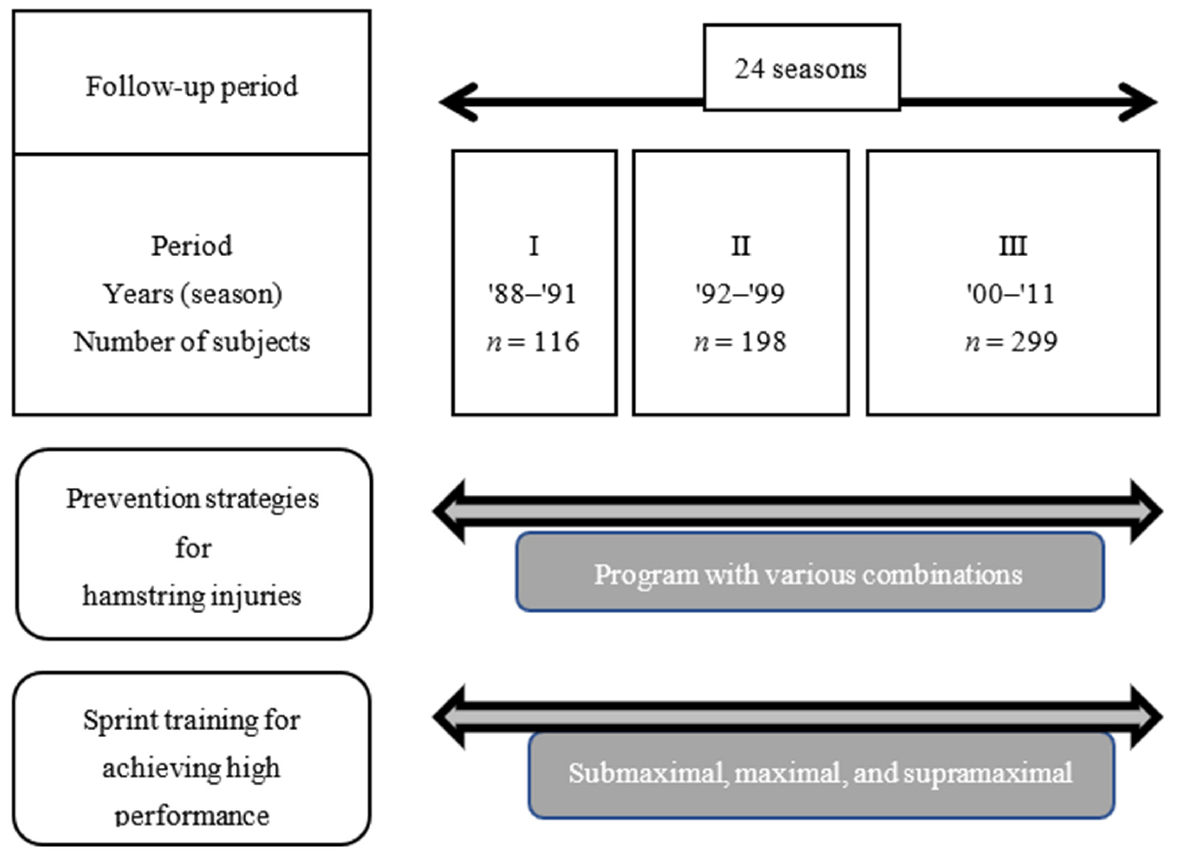
Figure 1. Study Figure 1. Study design.